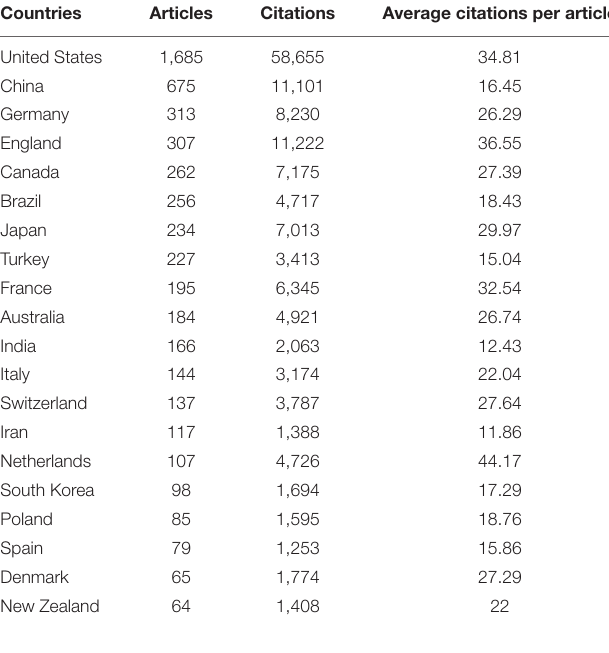
TABLE 1 | Number of publications and citations by